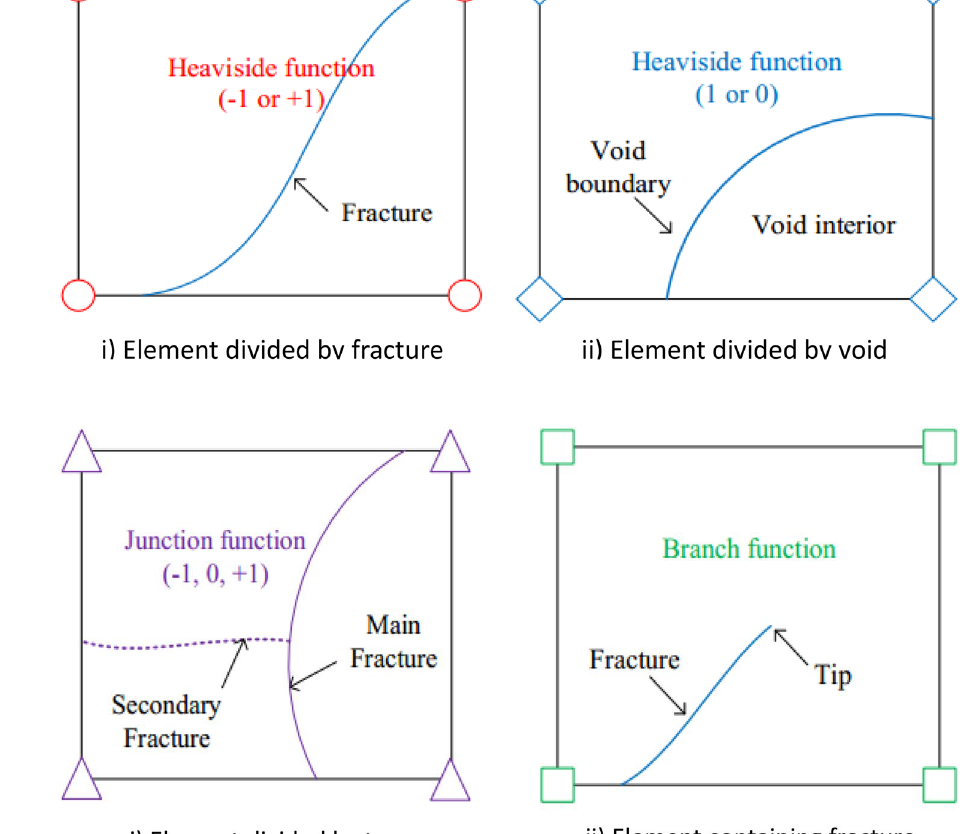
Fig. 2 Heaviside enrichment function (Youn 2016)